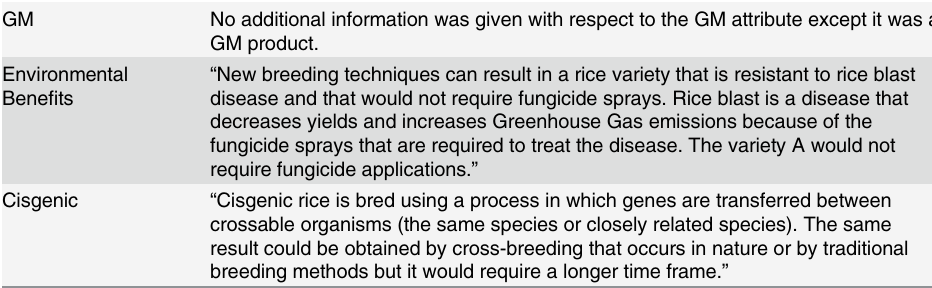
Table 2. Descriptions of Variety A